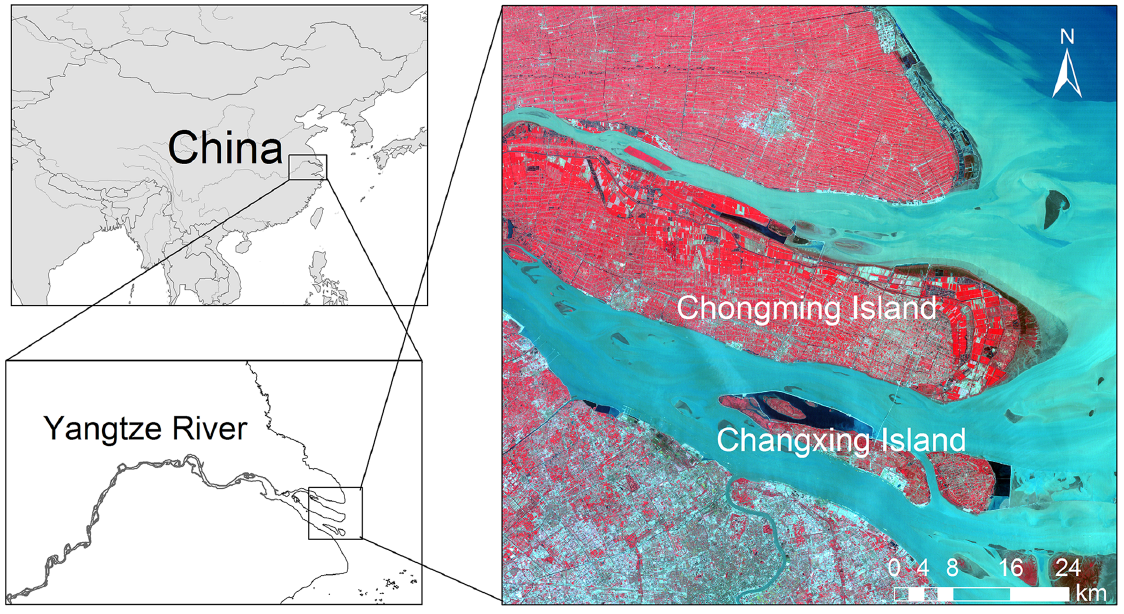
Figure 1. Location of the study area. doi:10.1371/journal.pone.0070079.g001 PLOS ONE |